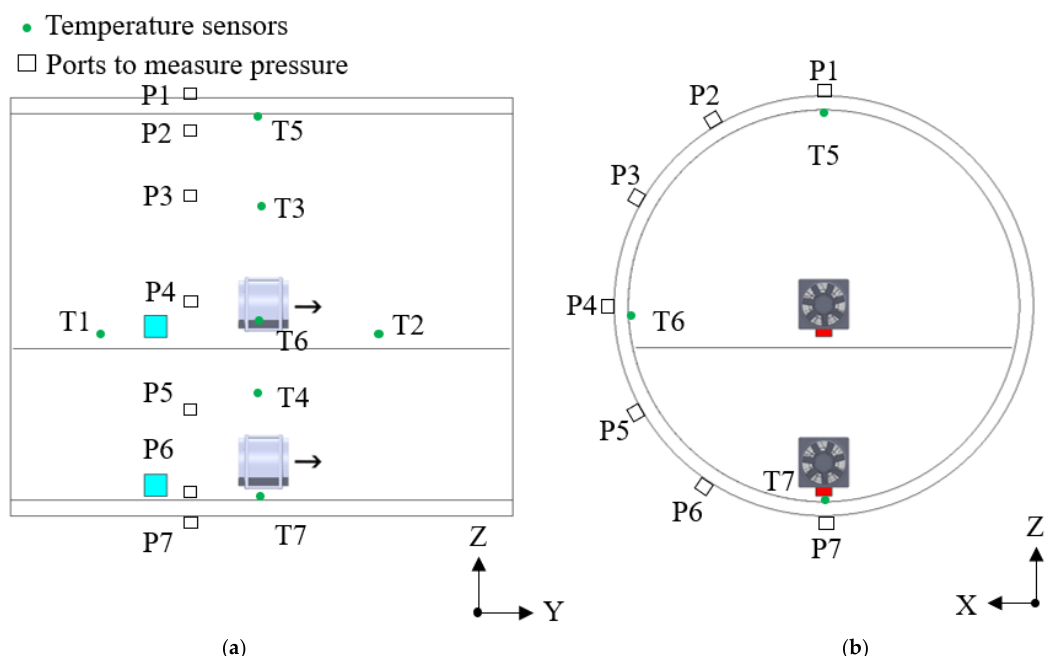
Figure 4. Schematics of temperature and pressure measurement locations: ( a ) longitudinal sectional view; ( b ) front cross-sectional view.